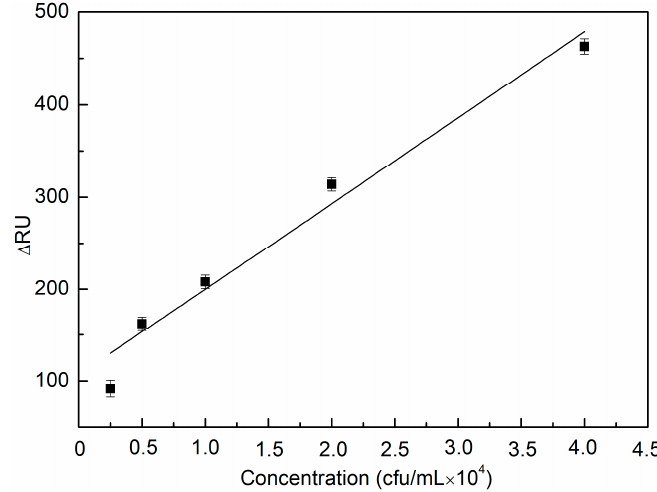
Figure 5. The relationship between different concentrations of E. coli O157:H7 and the SPR response signals.